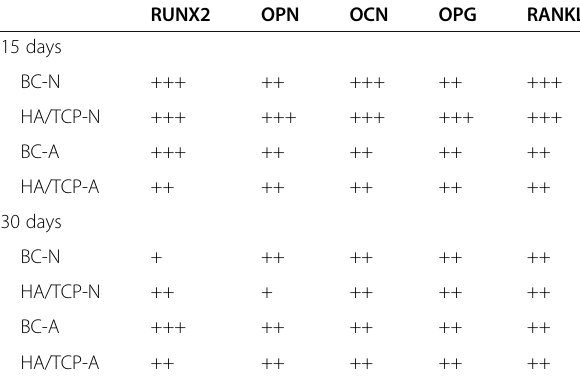
Table 4 Representative scores (most frequently observed) of the immunolabeling, categorized as mild/discrete (+), moderate (++), or intense (+++), according to the area/quantity of positive cells for each antigen in all groups in both periods